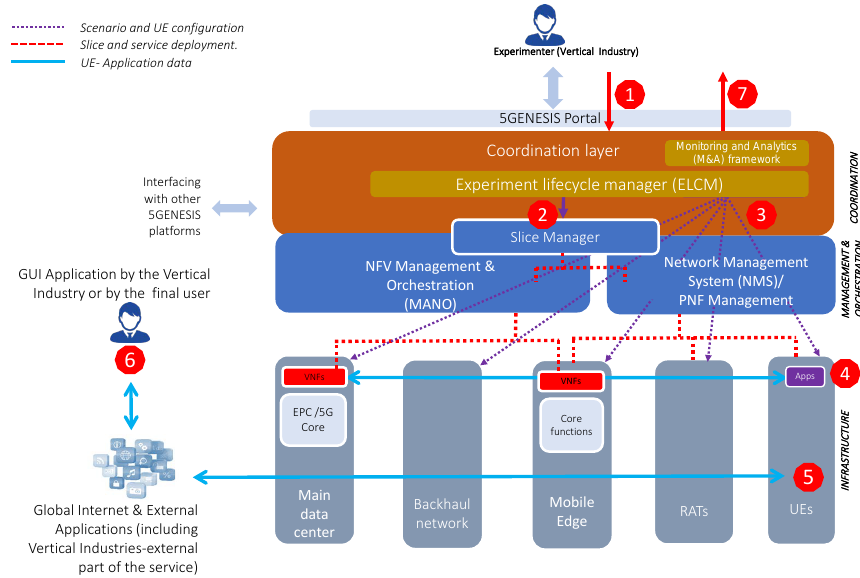
Figure 1. 5GENESIS Reference Architecture and Experimentation